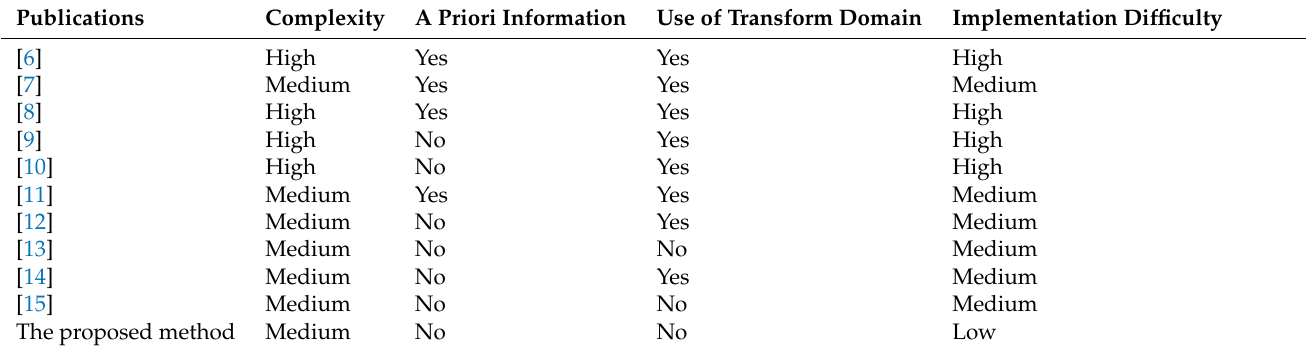
Table 1. Comparison between prominent studies in the literature on several